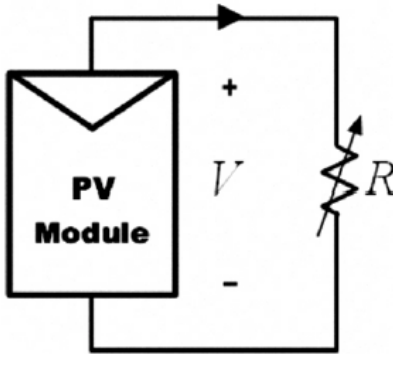
Figure 10. Variable resistor scheme [24].